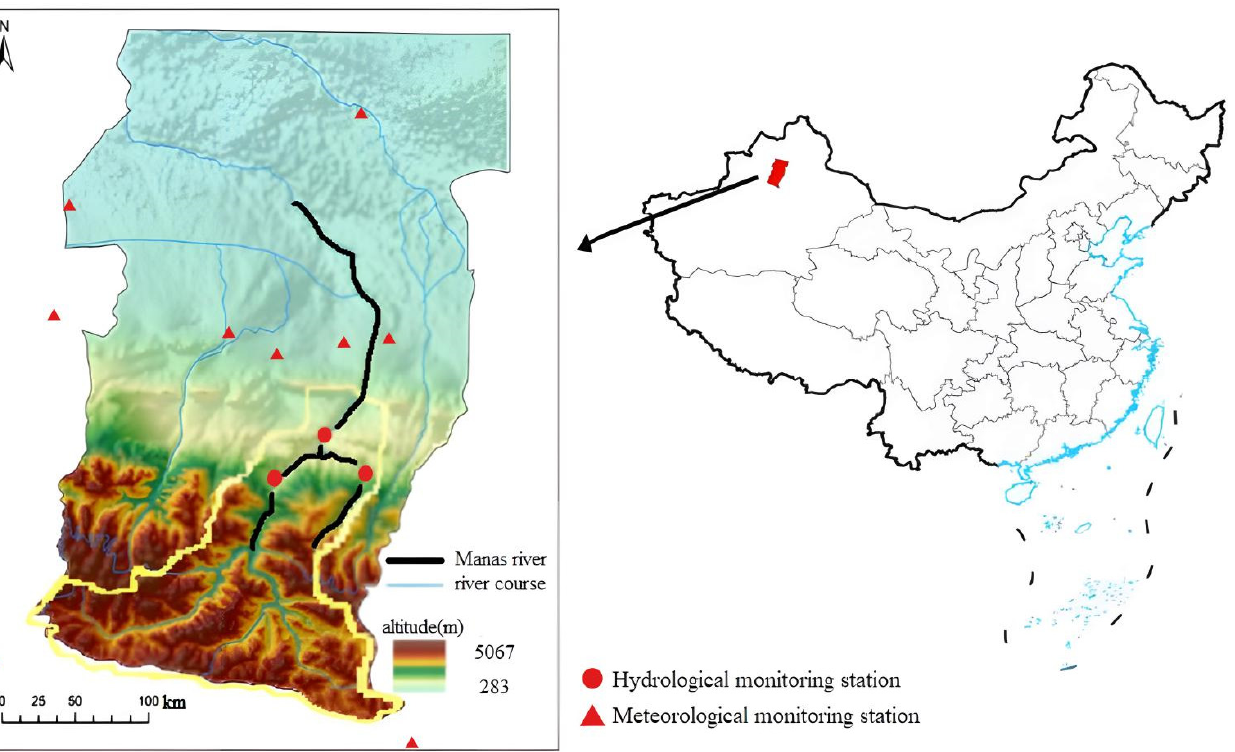
Figure 1. Sites in the study area, with DEM distribution. The map is from Chinese Standard Map (http://bzdt.ch.mnr.gov.cn/, GS (2019)1822 (accessed on 22 November